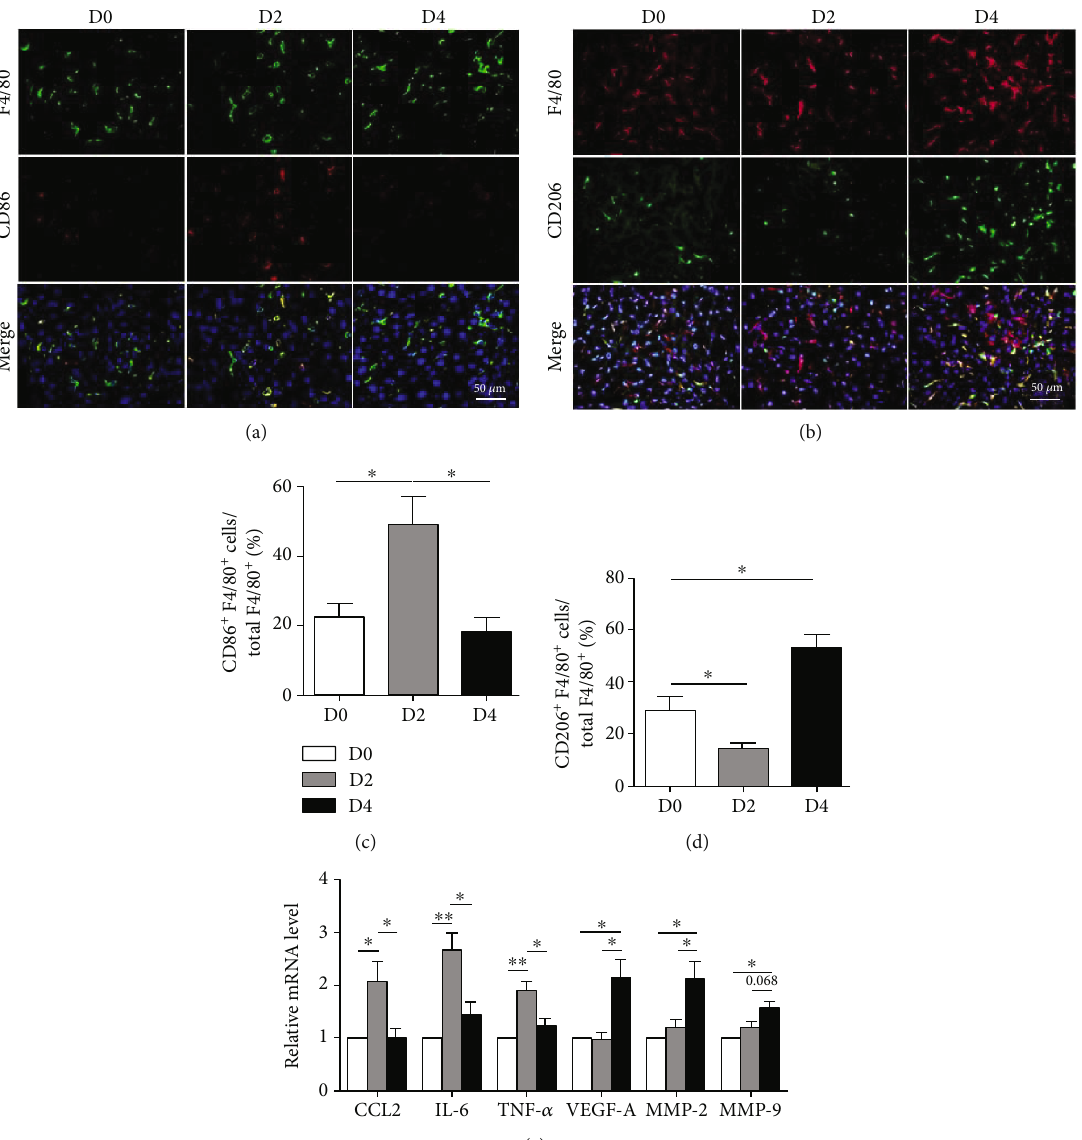
Figure 3: The functions of activated macrophages were determined after PHx. (a, b) C57BL/6 mice were sacri fi ced at D2 or D4 after 2/3 PHx or sacri fi ced immediately after sham operation. Liver sections were stained with (a) anti-F4/80 and anti-CD86 antibodies or (b) anti-F4/80 and anti-CD206 immuno fl uorescence and counterstained with Hoechst. (c, d) The percentage of double-positive cells in macrophages were determined and quantitatively compared in (a, b). (e) F4/80 + macrophages were sorted by MACS from HNPCs, and the mRNA levels of CCL2, IL-6, TNF- α , VEGF-A, MMP-2, and MMP-9 were determined by qRT-PCR. Bars = means ± SD , n = 5 . ∗ P < 0 : 05 , ∗∗ P < 0 : 01